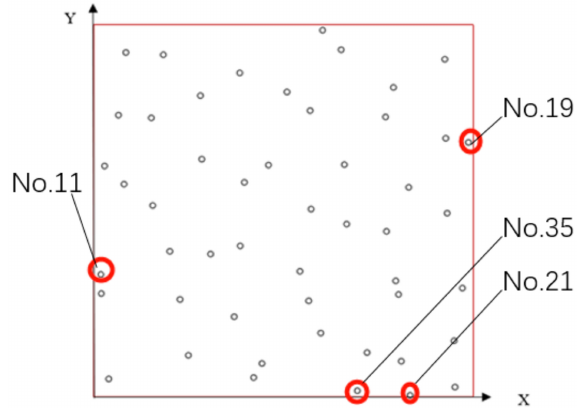
Figure 29. Points where the vertical displacements of the thin plate are